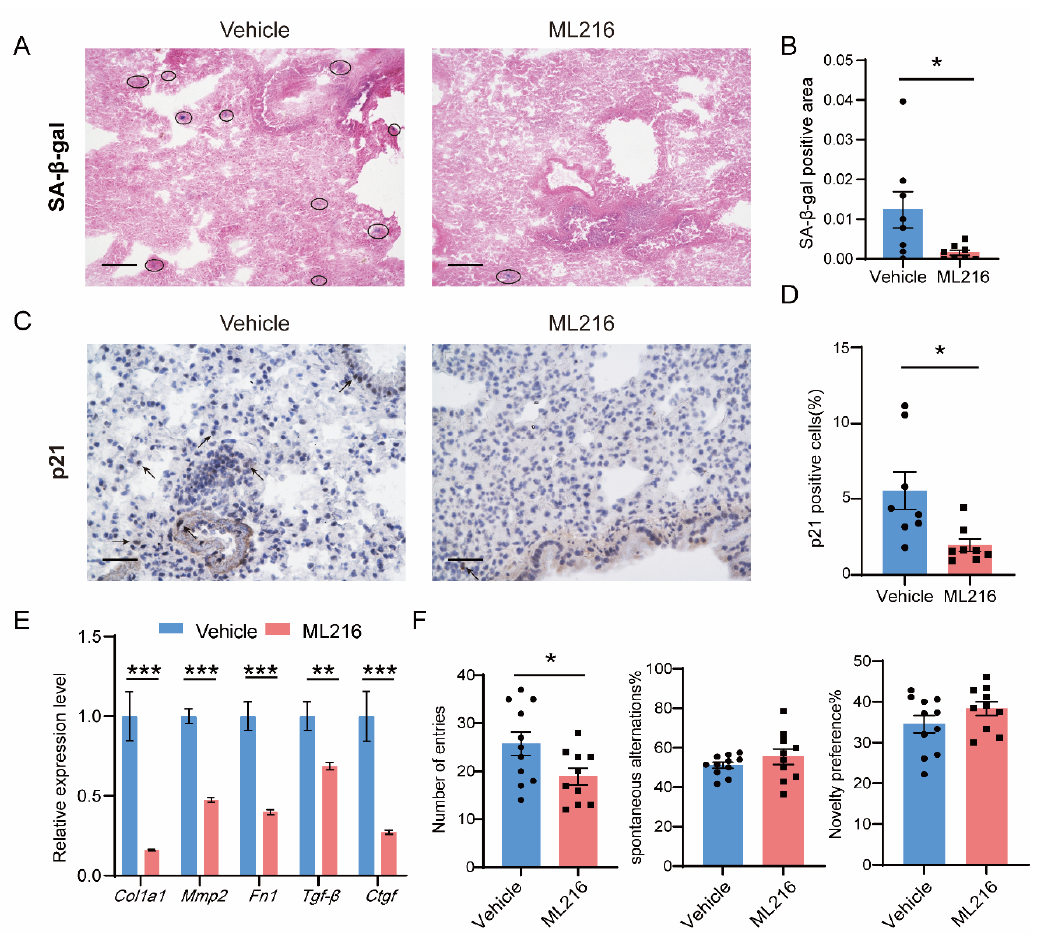
Figure 6. ML216 alleviates senescence in vivo and improves health in naturally aged mice. Two groups of 22-month-old mice were subjected to intraperitoneal injection with vehicle or 1 mg/kg ML216 twice a week for 5 weeks. ( A ) Representative images and ( B ) the quantification of SA-β-gal-positive cells in 22-month-old mice lungs (Vehicle, n = 8; ML216, n = 8). Scale bar = 100 μm. SA-β-gal-positive cells are blue areas indicated by black circles. ( C ) Representative images and ( D ), the quantification of p21-positive cells in mice lungs (Vehicle, n = 8; ML216, n = 8). Scale bar = 50 μm. P21-positive cells are indicated with arrowheads. ( E ) Gene expression levels of fibrosis marker genes COL1A1 , MMP2 , FN1 , TGF-β and CTGF in mice lungs (Vehicle, n = 9–11; ML216, n = 8). ( F ) Number of arm entries, spontaneous alternations and novelty percentage in Y-maze test (Vehicle, n = 11; ML216, n = 10). In ( B , D , F ), the black circles represent mice in vehicle group, the black squares represent mice in ML216 group. All data were presented as mean ± SEM.